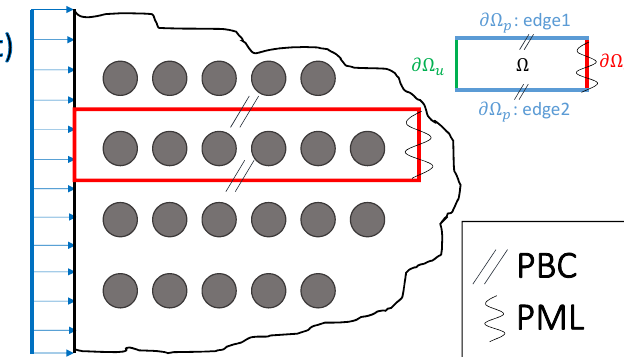
Figure 2. 2D simulation model of a solid with circular inclusions: this semi-infinite solid can be represented by only modeling only the part inside the red rectangule with Periodic Boundary Conditions (PBC) and Perfect Matched Layers (PML) as drawn; Grey disks represent the inclusions. ( Ω represents simulation domain, ∂ Ω indicates boundary conditions)